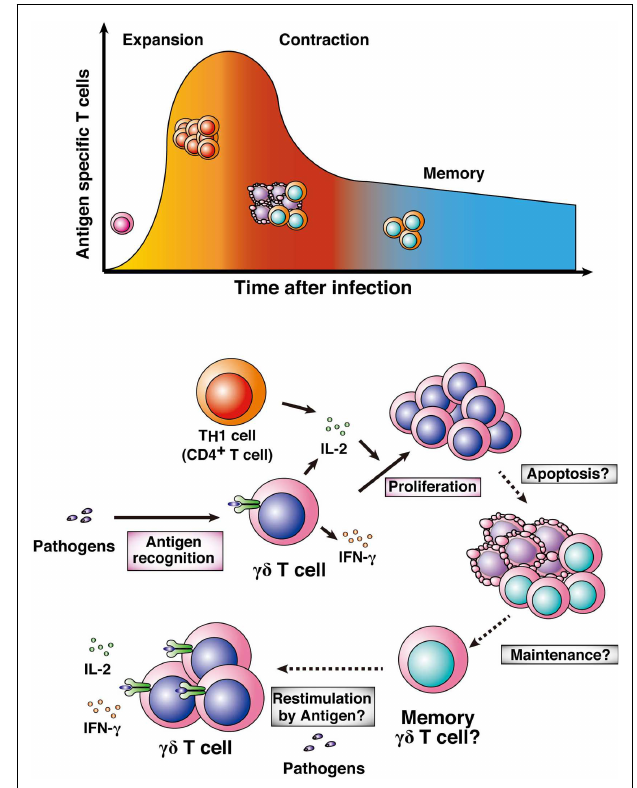
FIGURE 4 | Memory γδ T cells . NaïveT cells are activated by pathologic infections and differentiate into effector or killerT cells. ActivatedT cells clonally expand in response to particular antigens (expansion phase). After pathogen clearance, high proportions of the expanded antigen-specificT cells undergo apoptosis (contraction phase). Some population of the surviving antigen-specificT cells is maintained as memoryT cells (memory phase). γδ T cells also expand after infection with pathogens, including Plasmodium parasites. High-level proliferation of γδ T cells is involved in generating IL-2 fromT H 1 cells or the γδ T cells themselves. It remains to be determined whether antigen-specific γδ T cells shift into a contraction phase and then a memory